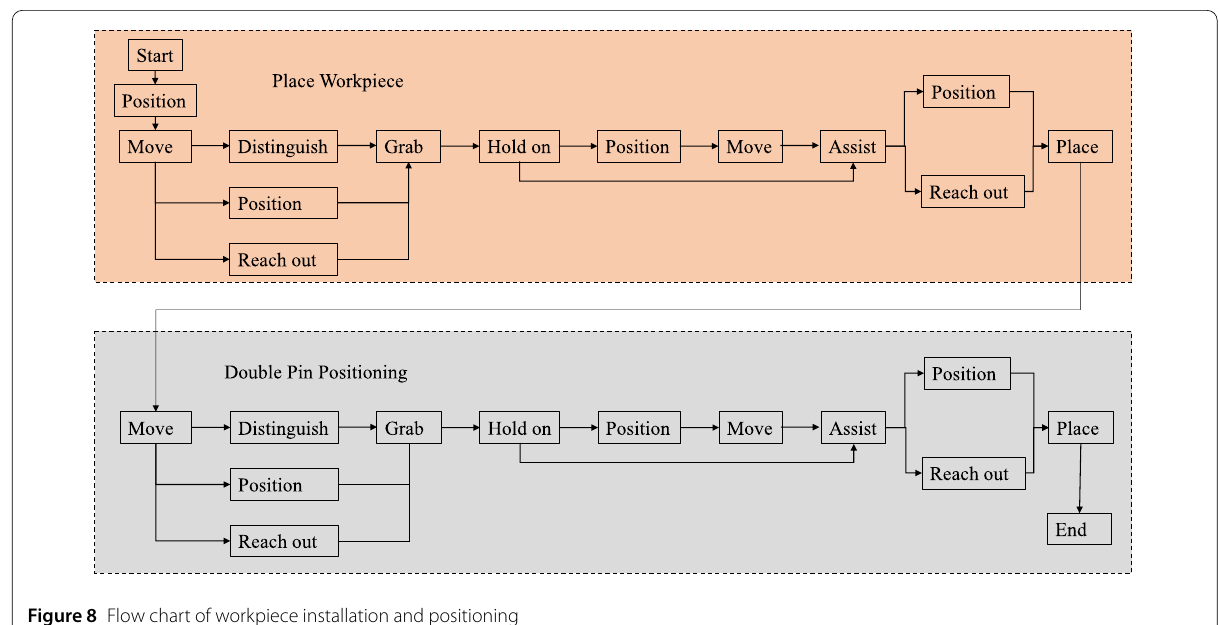
Figure 8 Flow chart of workpiece installation and positioning